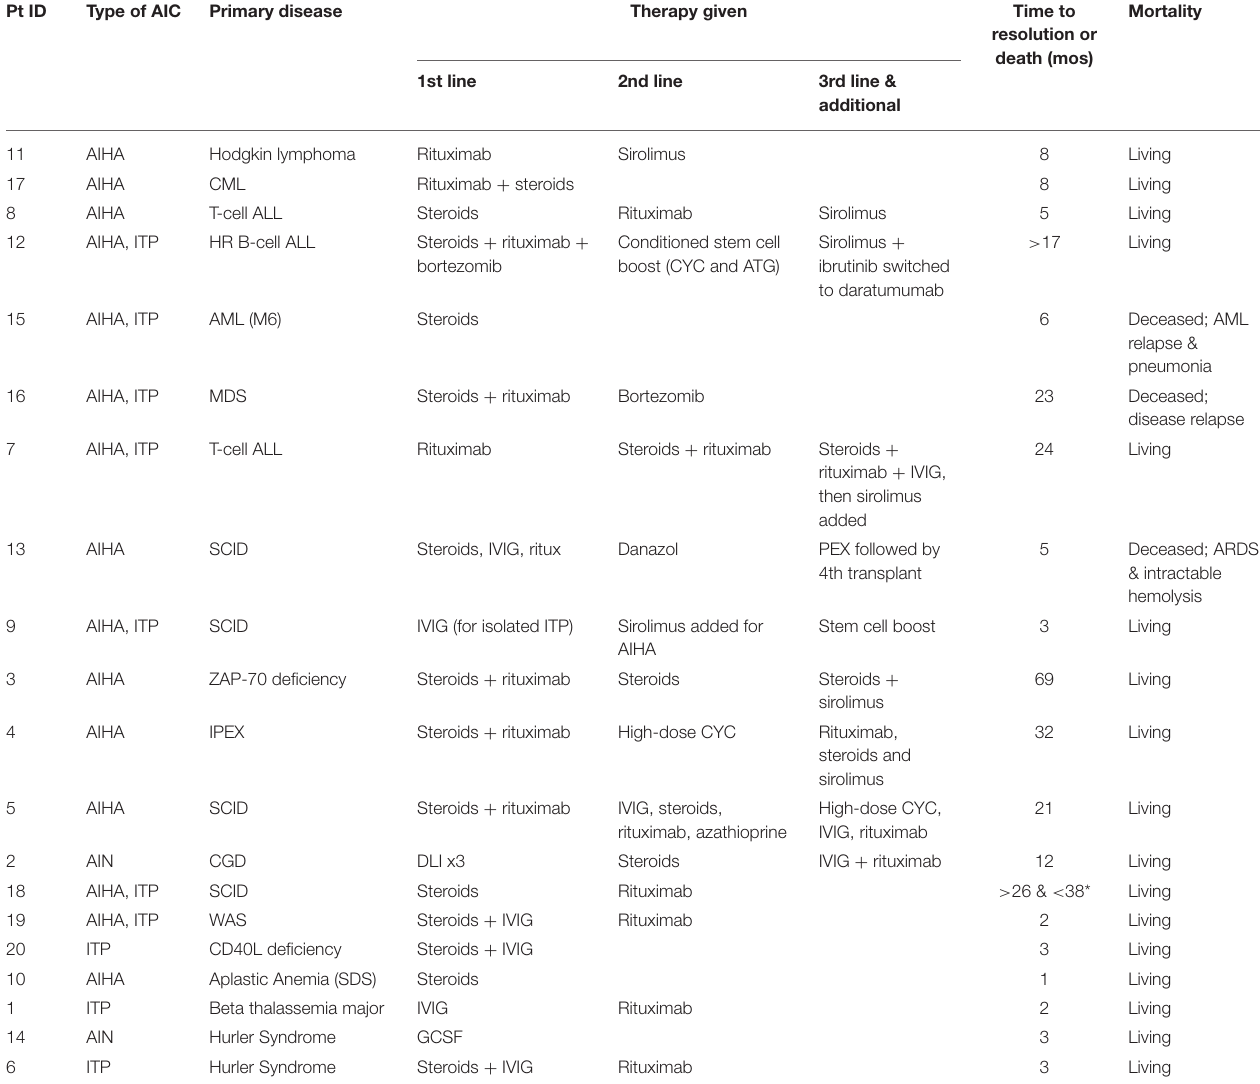
TABLE 3 | Treatment and